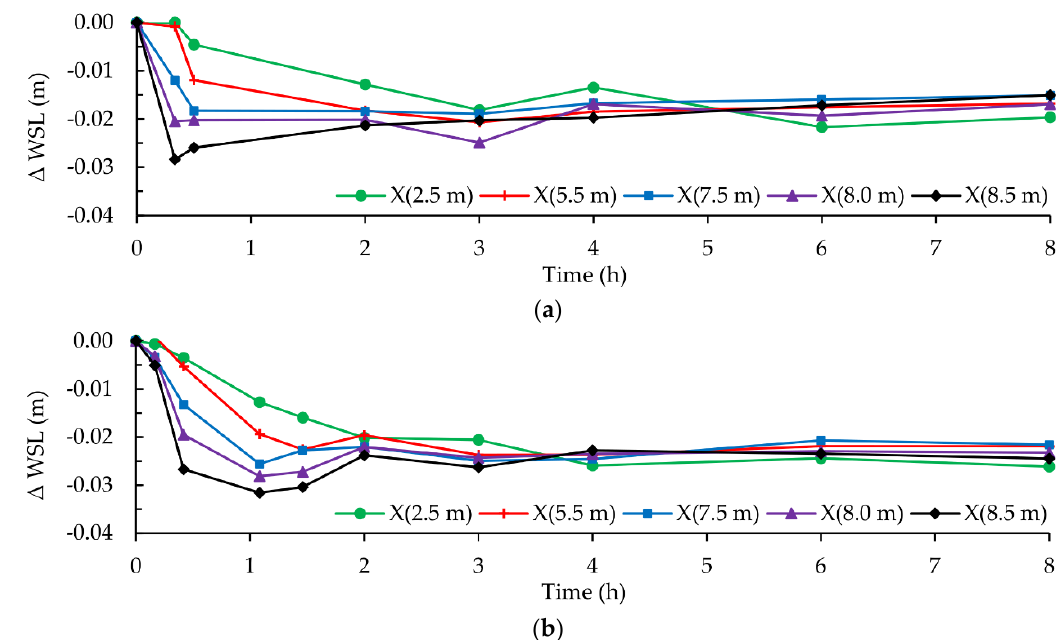
Figure 5. Water surface changes over the experimental time for di ff erent stations (X): ( a ) test run E1; ( b ) test run E2.